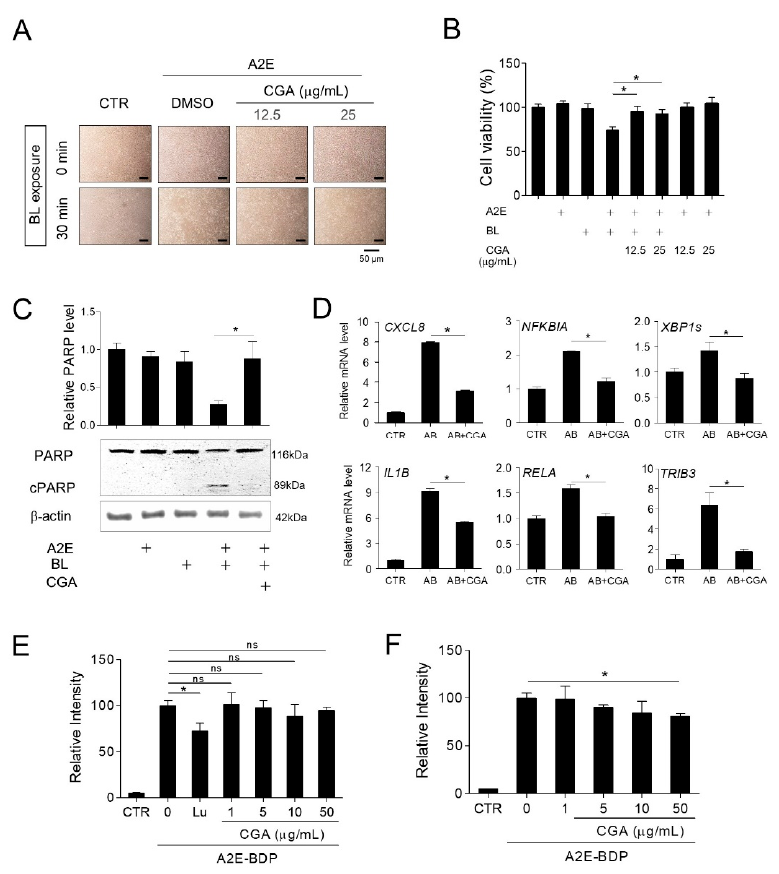
Figure 7. Chlorogenic acid (CGA) is an active substance in EPX that protects retinal cells from A2E- and blue light- induced damage. ( A , B ) Protection of retinal cells by CGA. EPX ARPE-19 cells were treated with A2E, CGA (12.5 and 25 μ g/mL), and blue light, as shown in Figure 2A. Cell viability was visualized using an inverted phase-contrast microscope and monitored by EZ-Cytox. ( C ) Reduction of PARP cleavage by CGA. A2E-laden RPE cells were treated with CGA (12.5 μ g/mL) for 48 h before blue light illumination. Western immunoblot analysis indicated full-length PARP and cleaved PARP (cPARP) protein expression and the band intensities were quantified by densitometric analysis. The results are presented as the mean ± S.D. ( n = 3); * p < 0.05. ( D ) The effect of CGA on the expression of pro-inflammatory genes. The mRNA levels were measured by RT-qPCR in CGA (25 µ g/mL)-treated cells. ATF3 —activating transcription factor 3; XBP1s —spliced X-box-binding protein 1; TRIB3 —tribbles pseudokinase 3. The results are presented as the mean ± S.D. ( n = 4); * p < 0.05. ( E ) The effect of CGA on A2E accumulation in ARPE-19 cells. ARPE-19 cells were pretreated with CGA (1–50 µ g/mL) for 24 h before treatment with A2E-BDP (10 µ M). The relative fluorescence intensity was measured using a fluorescence microplate reader. Lutein (Lu, 30 µ M) was used as a positive control. ( F ) The effect of CGA on the degradation of A2E in ARPE-19 cells. Cells were incubated with A2E-BDP (10 µ M) for 24 h before treatment with CGA (1–50 µ g/mL). Intracellular A2E-BDP level was monitored, as shown in Figure 6. The results are presented as the mean ± S.D. ( n = 4); * p <